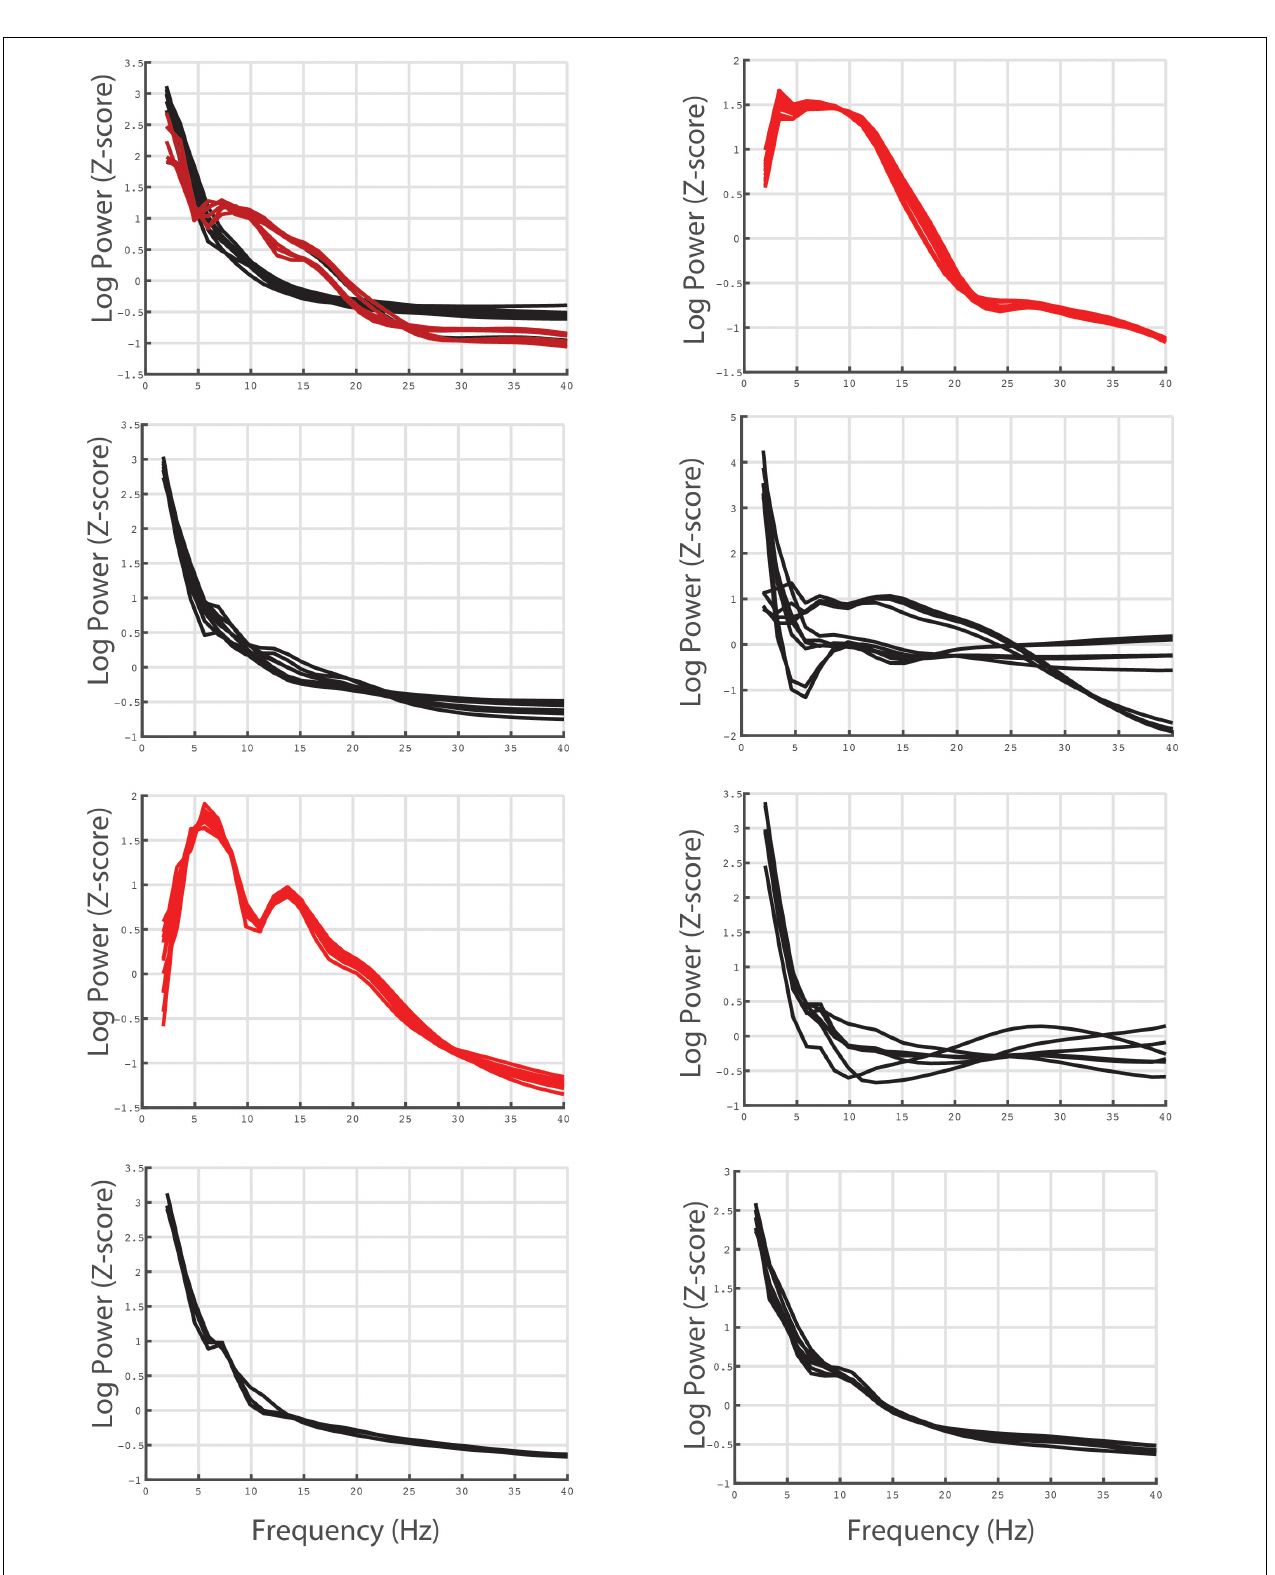
FIGURE 8 | Averaged power spectra for each bipolar electrode pair recording for all individual subjects. The average power spectra for each bipolar recording (see text for calculation) are shown for all patients in the database. The red traces represent bipolar recordings derived from thoracic electrodes and the black traces represent bipolar recordings derived from cervical